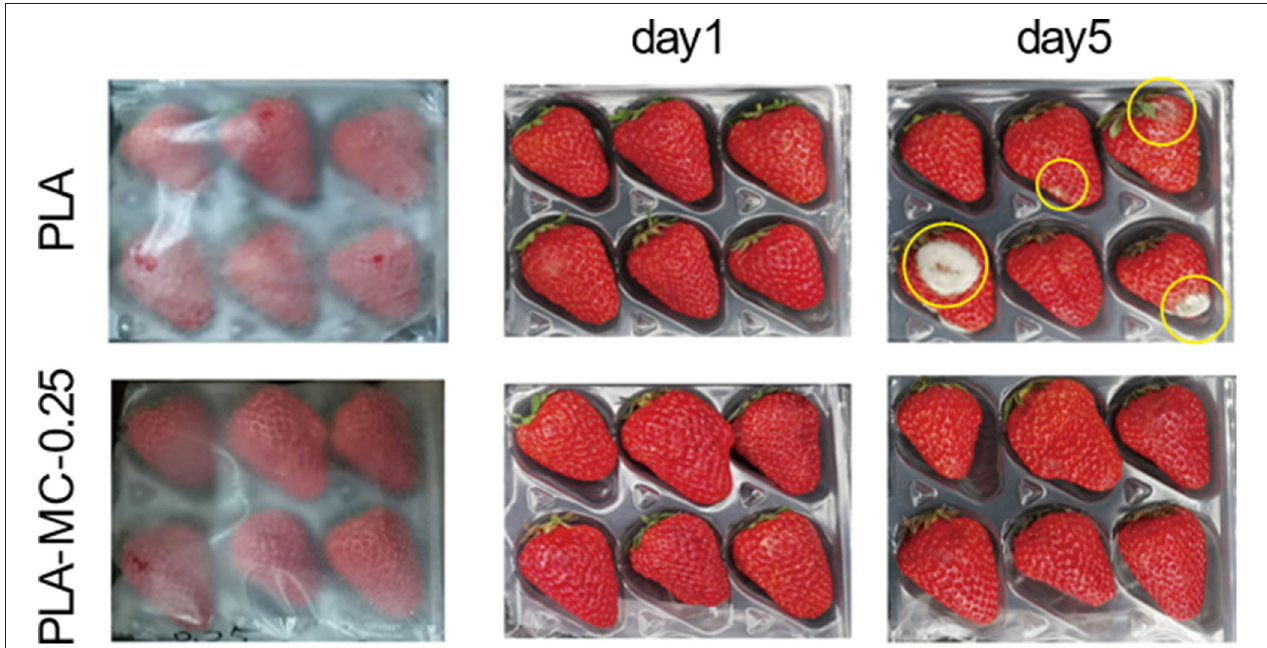
FIGURE 6 | Strawberries packaged with the PLA films and the MC–PLA-0.25 on days 1, 3, and 5.